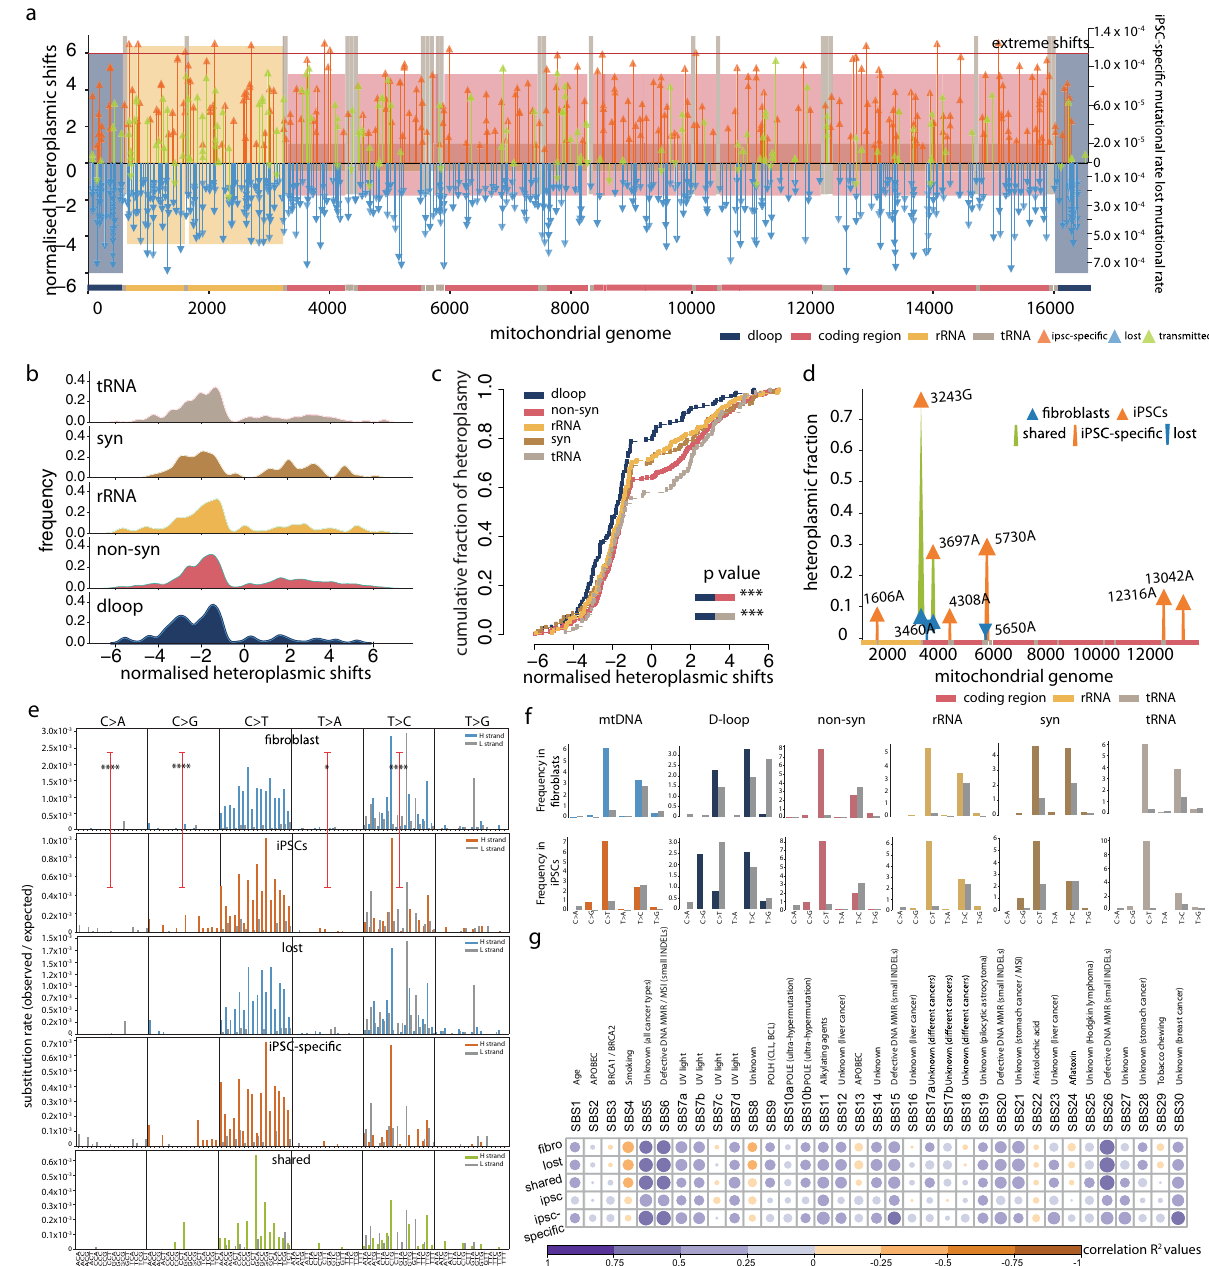
Fig. 3 The spectrum of mtDNA mutations changes during cell reprogramming. a Normalised heteroplasmic shifts (HS) estimated between 83 fi broblast cell lines and 141 derived iPSC lines. Normalised heteroplasmic shifts are shown on the left side of the y axis. mtDNA regions shown by different colours; the depth of shading represents the mutation rate of iPSC-speci fi c variants and lost variants within each mtDNA region (shown on the right side of the y axis). Variants above the red lines were extreme shifts seen in iPSCs. Source data are provided as a Source Data fi le . b Distributions of the HS in different mtDNA regions. c Cumulative distributions of the HSs within each mtDNA region. P values were calculated using two-sided Fisher ’ s exact test. d Pathogenic mutations observed in this study. Different colours represent lost, iPSC-speci fi c or shared mutations between fi broblast cell lines and derived iPSC lines. Blue triangles are HFs in fi broblasts and orange triangles are HFs in iPSCs. mtDNA regions shown at the bottom. e Trinucleotide mutational signature of heteroplasmic variants observed in fi broblasts, iPSCs, lost in fi broblasts, iPSC-speci fi c and shared variants between fi broblasts and iPSCs. The bars represent the substitution rate, mutations from the H or L-strand are shown in different colours. P values were calculated using two-sided Fisher ’ s exact test . f Mutational signature of six categories (C > A, C > G, C > T, T > A, T > C & T > G) within each mtDNA region. The bars represent the relative frequency of each category. Mutations from the H or L-strand are shown in different colours. g Correlation between mutational signatures observed in this study with the cancer signatures. The gradients of circles correspond to correlation R 2 values. The sizes of circles correspond to the p values (larger circles have smaller P values). The names of cancer signatures are shown at the